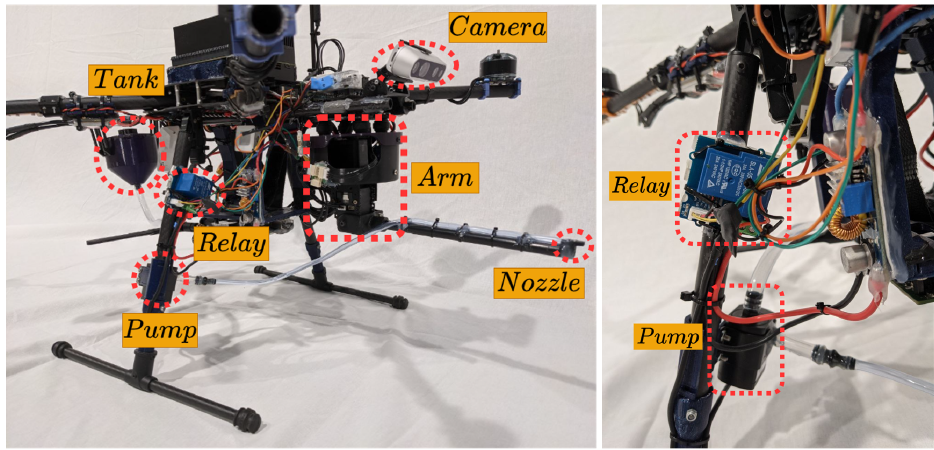
Figure 11. UAV hardware setup.